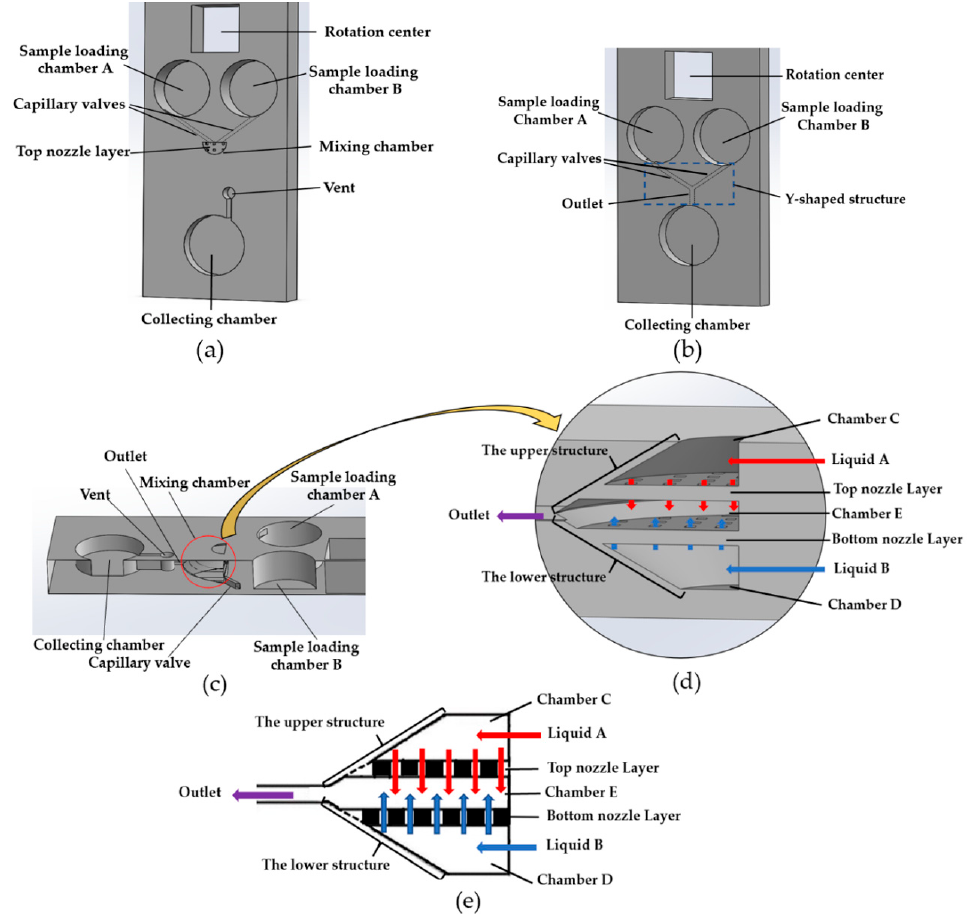
Figure 1. Design of the 3D jet mixer: ( a ) the exploded view of the assembly of the jet mixer to show the components; ( b ) design of the Y-shaped micromixer for comparison with the jet mixer’s performance; ( c ) the cross-sectional view on the right plane; ( d ) detailed design of the mixing chamber; ( e ) schematic diagram of the mixing chamber on the right plane.